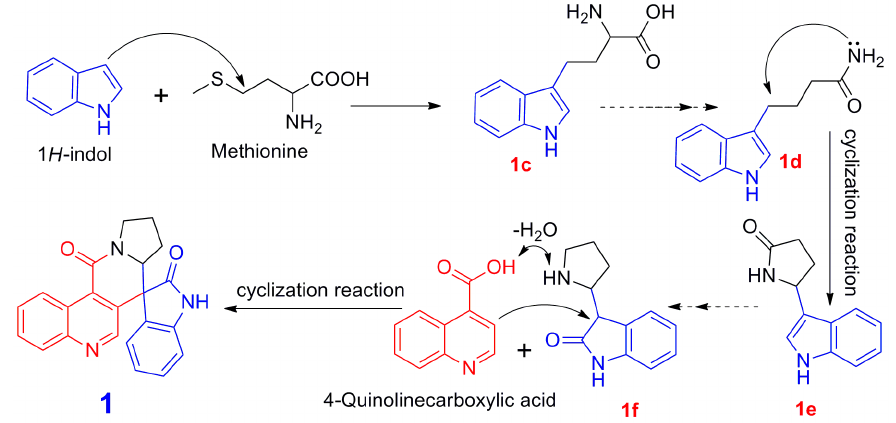
Figure 4. Putative biosynthetic pathway of compound 1.